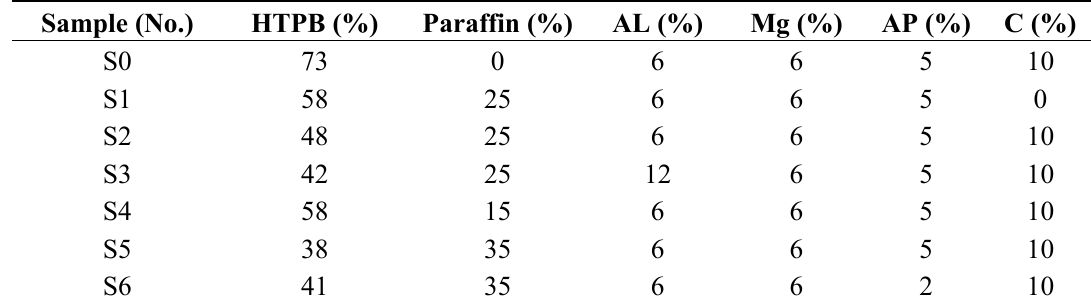
Table 1. The fuel formulation.